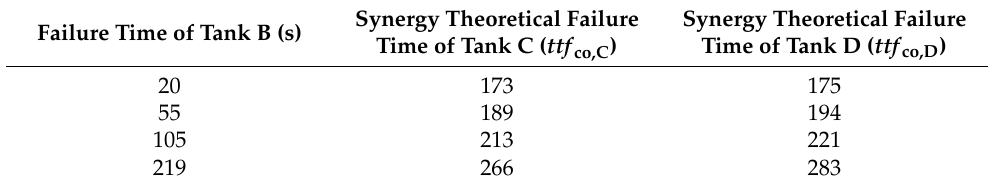
Table 2. Synergy theoretical failure time of tank C and D.